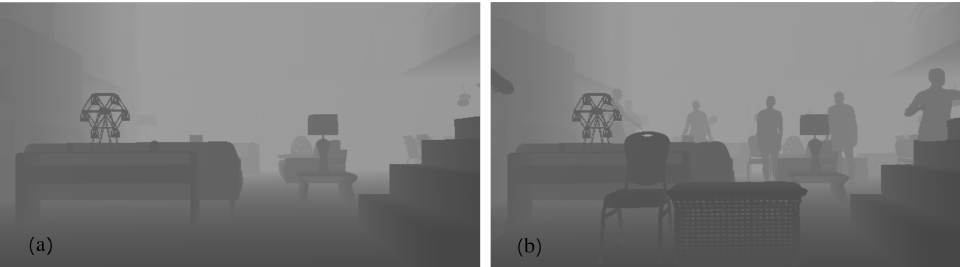
Figure 13. Shadow pass from GBuffer ( a ), shadow catcher mask ( b ), final shadow mask ( c ).